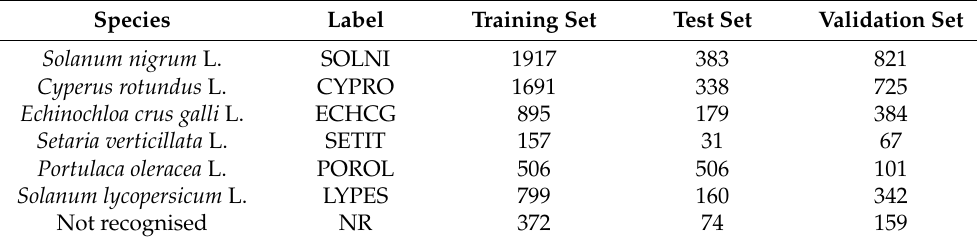
Table 1. Labelling weed species by EPPO code (European and Mediterranean Plant Protection Organization). Number of labels by bounding boxes in the Training set, Test set, and Validation set. Species Label Training Set Test Set Validation Set Solanum nigrum L. SOLNI 1917 383 821 Cyperus rotundus L. CYPRO 1691 338 725 Echinochloa crus galli L. ECHCG 895 179 384 Setaria verticillata L. SETIT 157 31 67 Portulaca oleracea L. POROL 506 506 101 Solanum lycopersicum L. LYPES 799 160 342 Not recognised NR 372 74